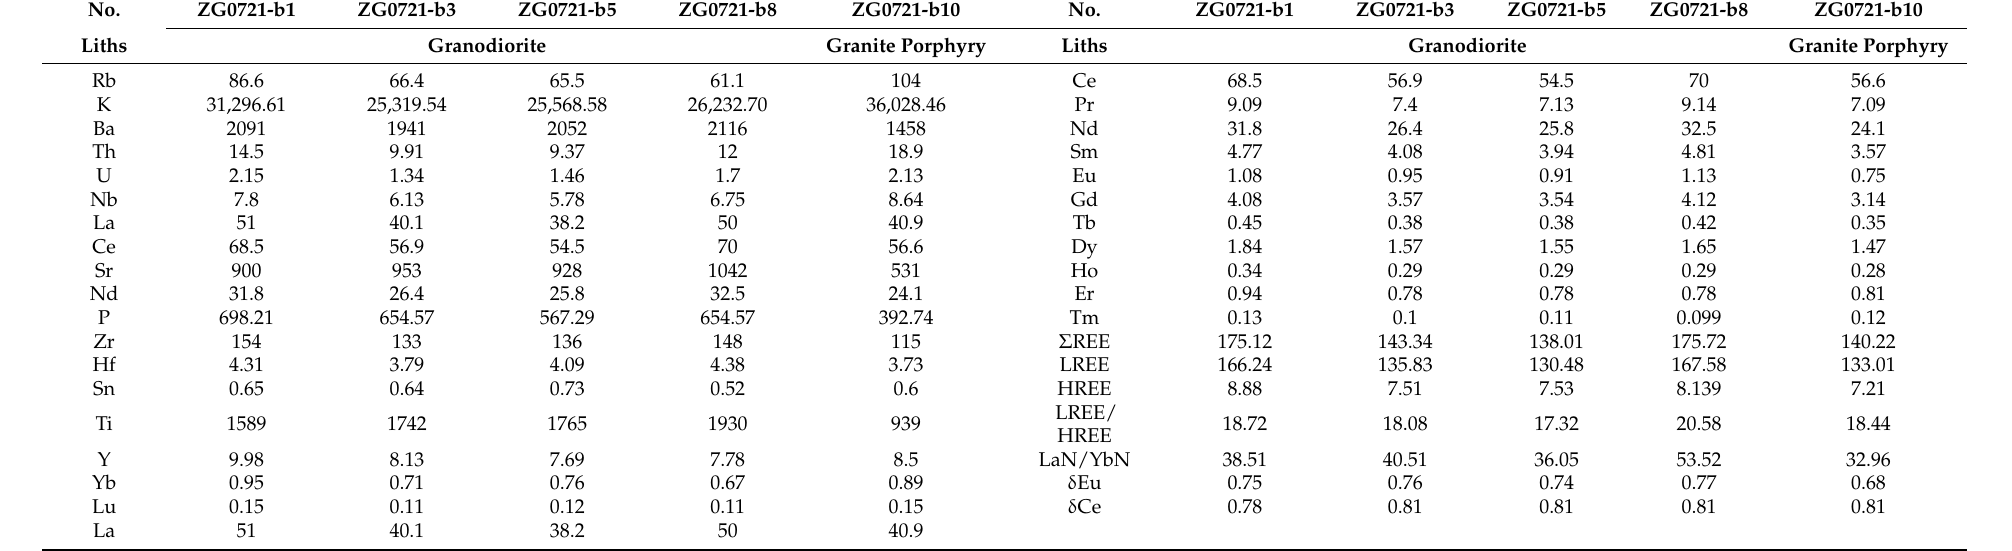
Table 2. Analysis results of trace and rare earth elements ( µ g/g) in the Zhouguan